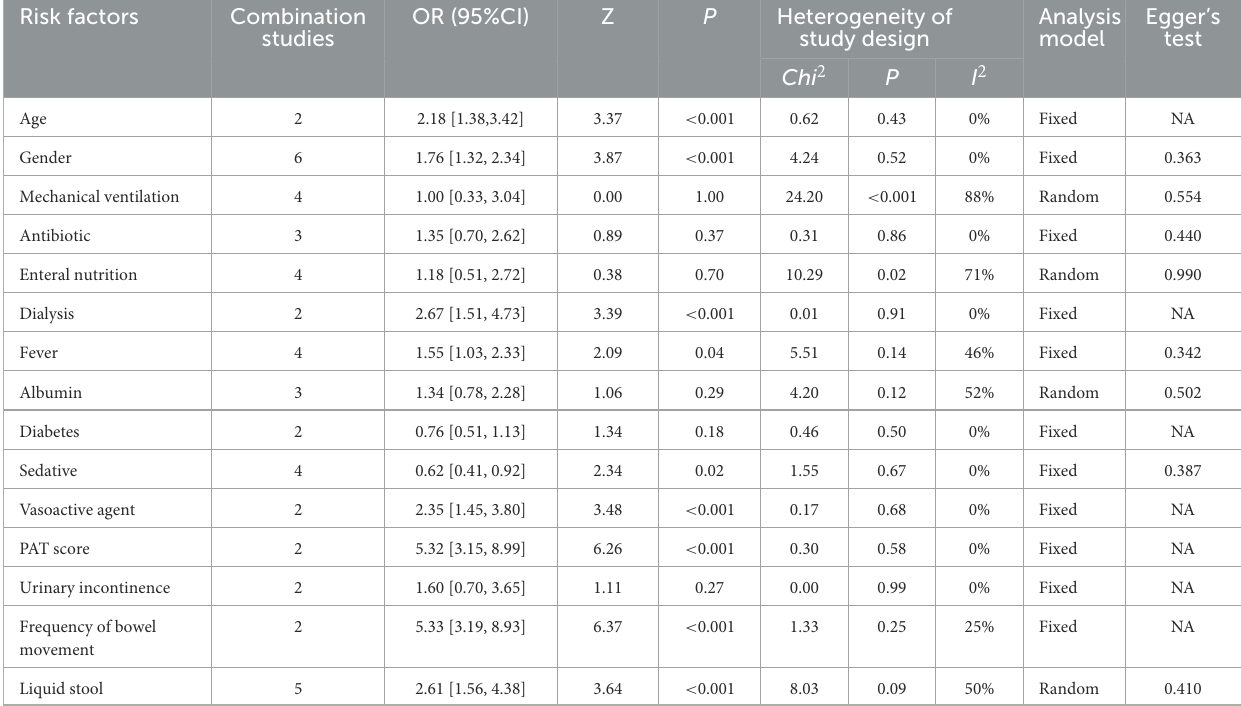
TABLE 2 Meta-analysis of risk factors of incontinence-associated dermatitis in critically ill